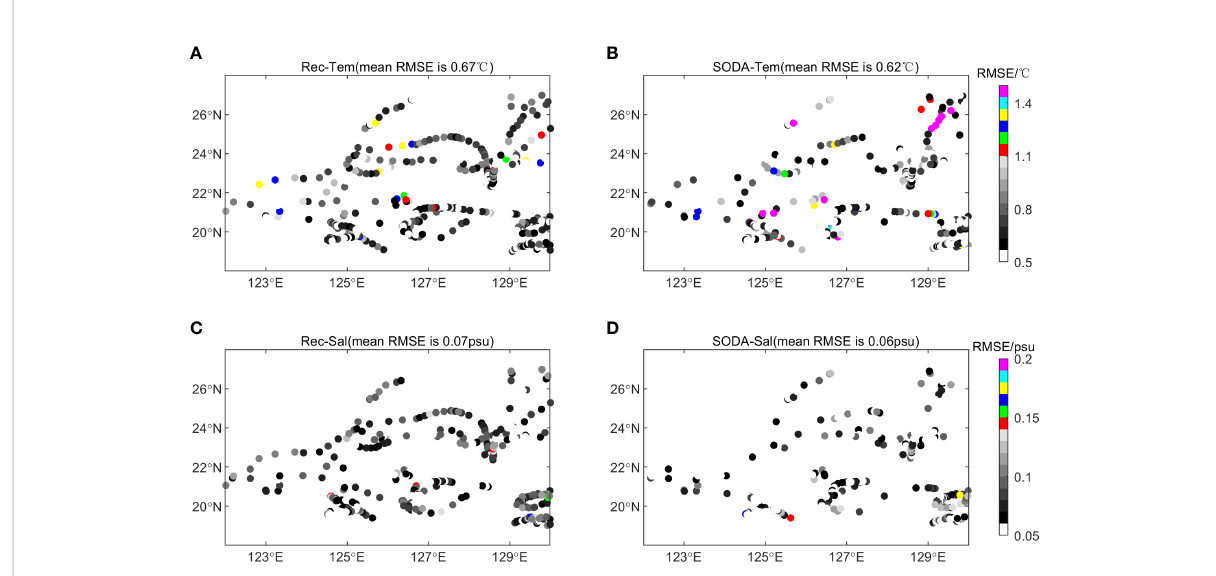
FIGURE 4 The distribution of RMSEs over space. Each row represents a different variable fi eld. Each column represents a different data source: (A, C) the synthetic fi elds and (B, D) the SODA3.4.2 reanalysis data.